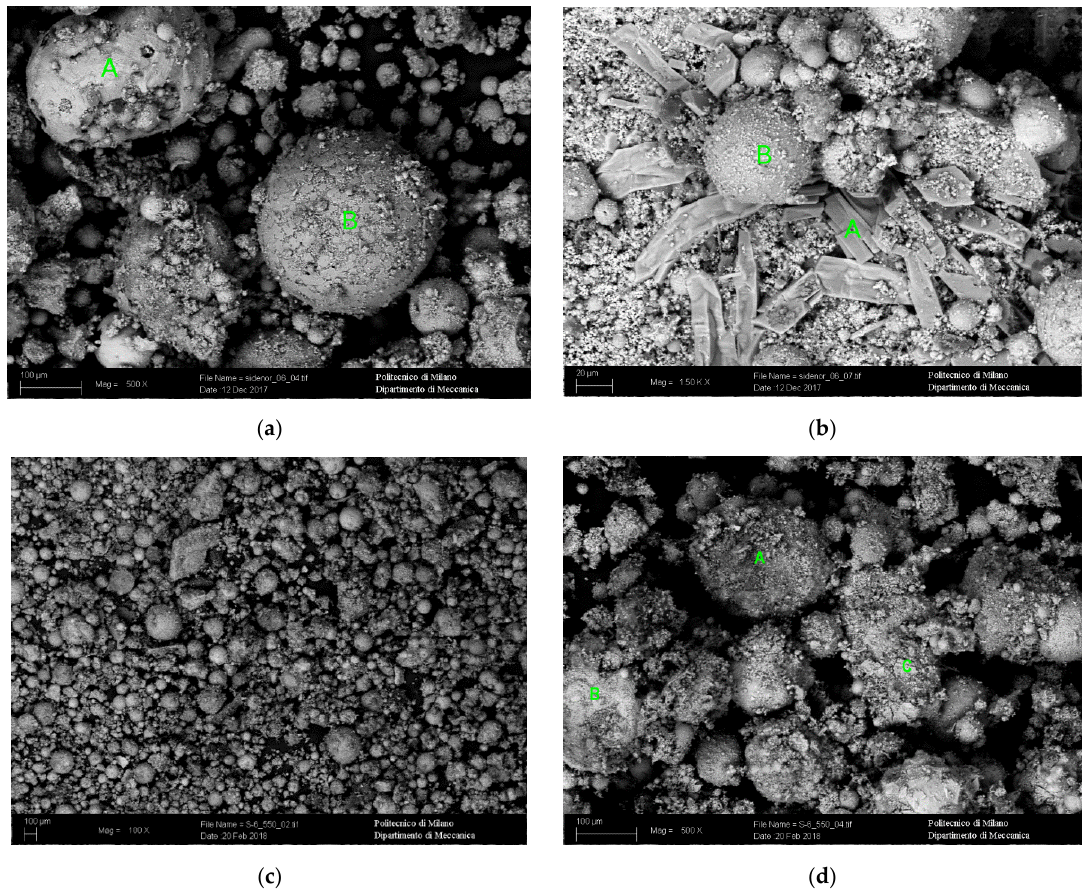
Figure 12. SEM micrographs of as-received ( a , b ) and 550 °C ( c , d ) treated fine combustion chamber residues. Table 10. SEM-EDS analysis of as-received and thermal-treated fine combustion chamber residues.